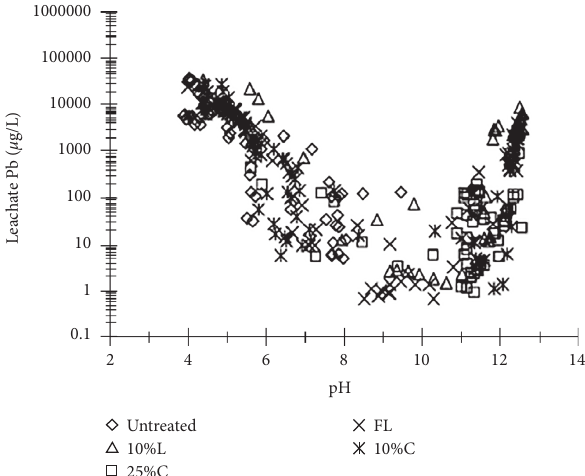
Figure 11: Experimental lead leachability in S/S-treated and un- treated samples determined with TCLP, DI, MEP, Ext TCLP, and infiltration